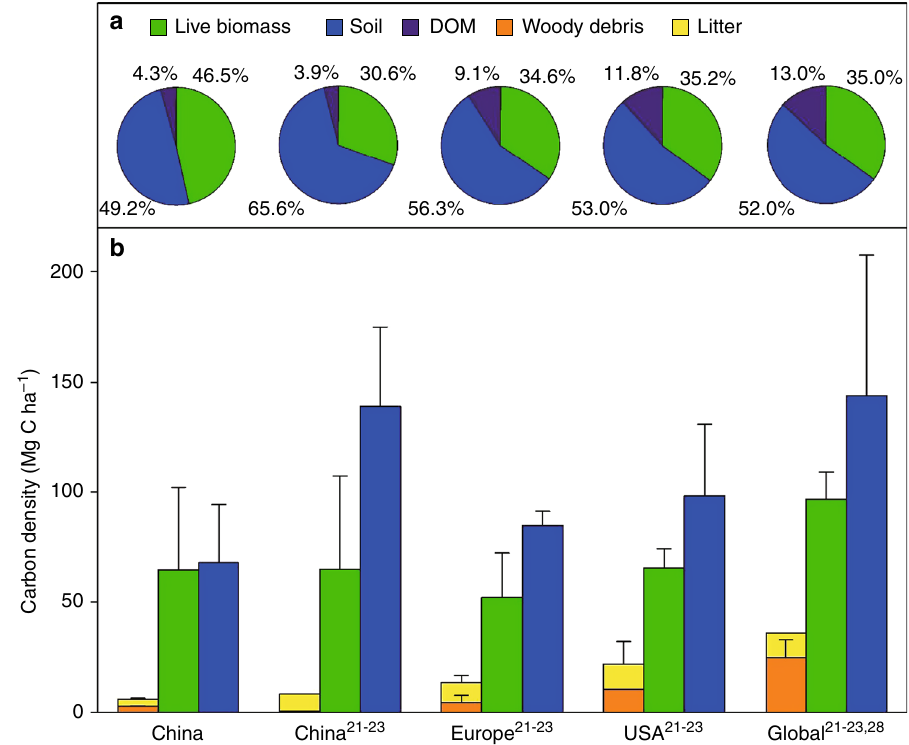
Fig. 6 Carbon density of each forest ecosystem component in China compared with the values reported in other regions. a The pie charts show the contribution (%) of dead organic matter, live biomass and soil to total ecosystem carbon stock. b Carbon densities (Mg C ha − 1 ) of the woody debris, litter, live biomass, and soil in China and other regions. The carbon density of Europe (geographic Europe), the United States, and the world are based on data reported in refs. 21 – 23, 28 . Carbon densities in this study are presented as means ± 1 SD, generated by 500 resamplings, and those in other studies are presented as means ± 1 SD from their reports ( n = 3 for China, Europe and the USA; n = 4 for the